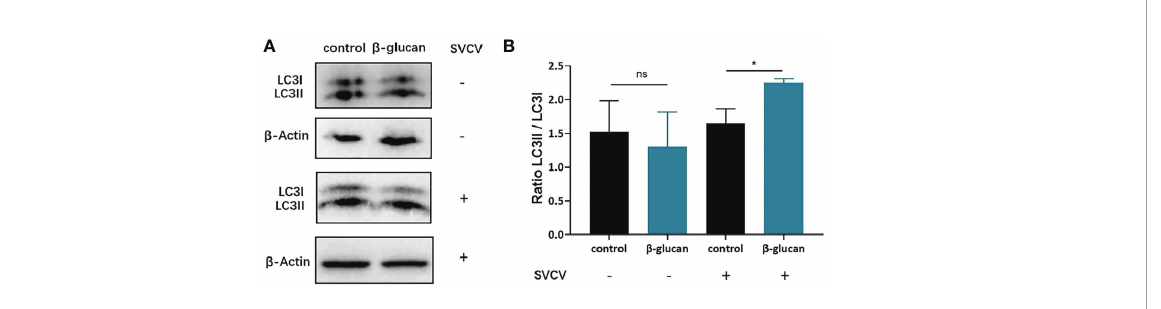
FIGURE 5 Effects of b -glucan on the LC3II/LC3I ratio post SVCV infection in ZF4 cells. (A) Western blot analysis of LC3 in ZF4 cells (n = 3); (B) LC3II/LC3I ratio in ZF4 cells were calculated by Image J software (n = 3). Values represent the means ± SEM. * P < 0.05, "ns" is a contraction of no signi fi cant.